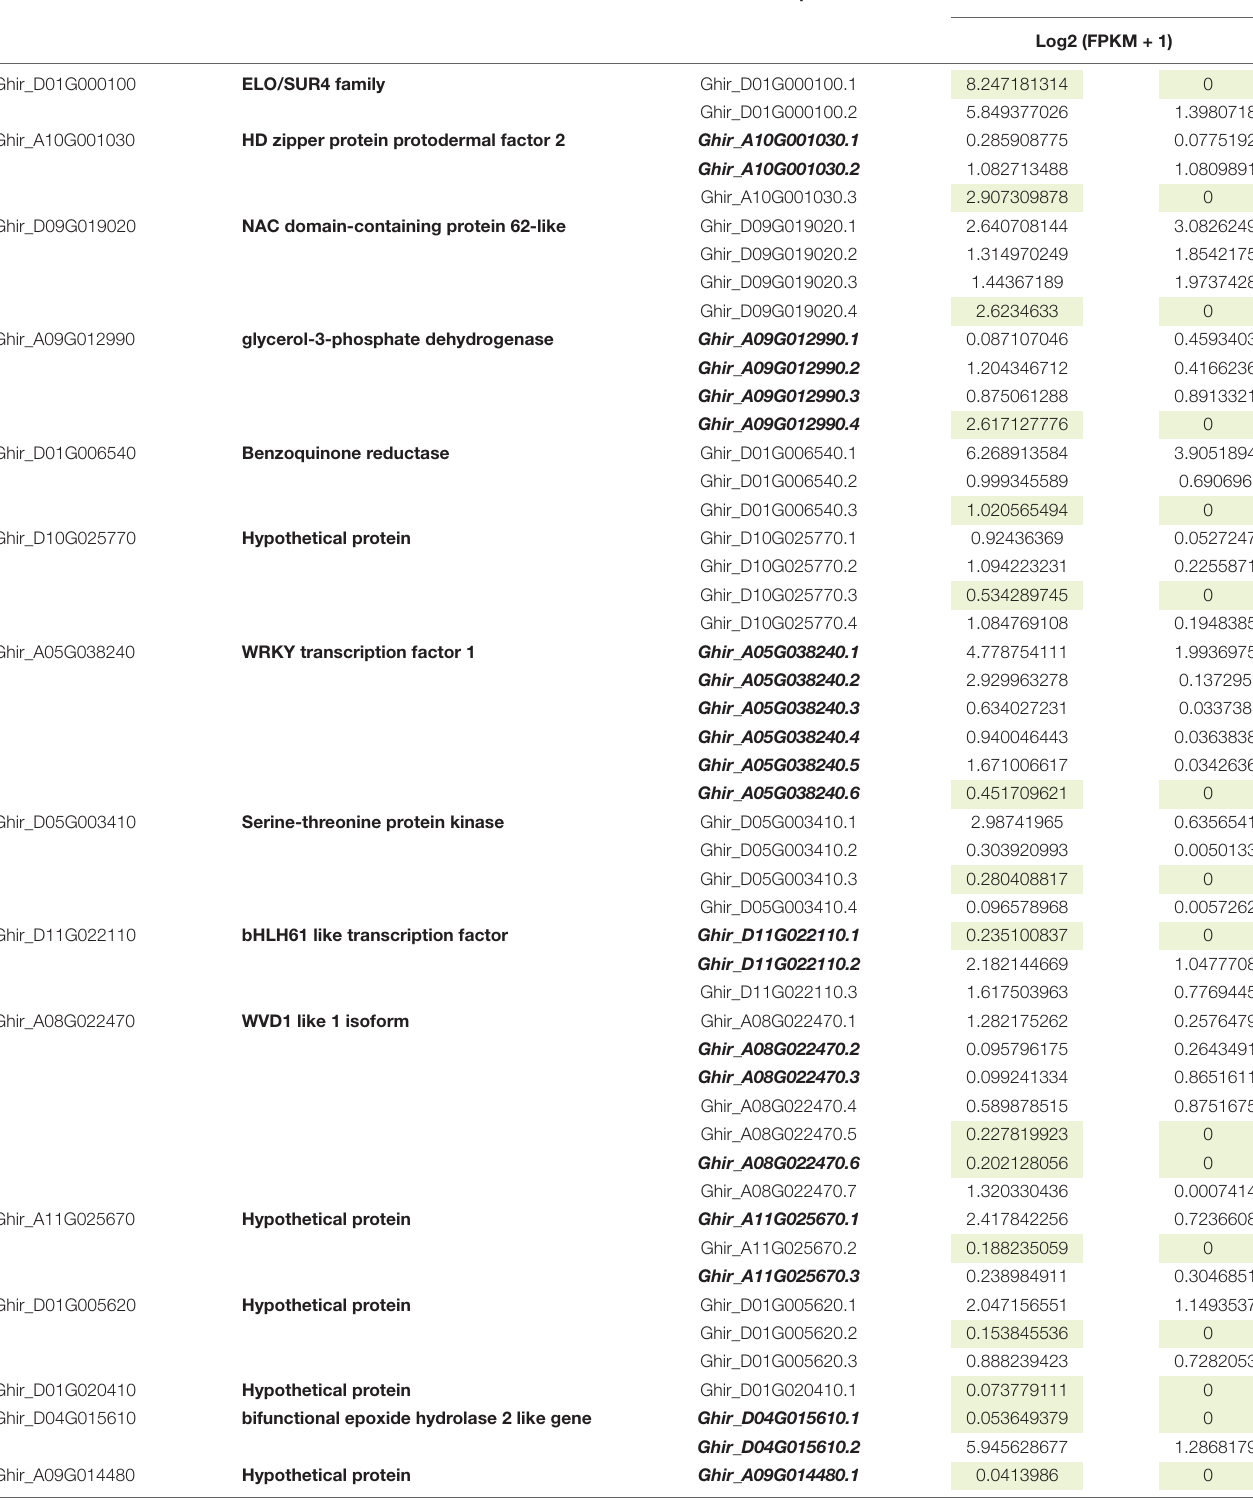
TABLE 1 | Detail information of Exclusively Expressed Transcripts (EETs), including their Arabidopsis -based annotation and log2 (FPKM + 1) value in OF and LRS